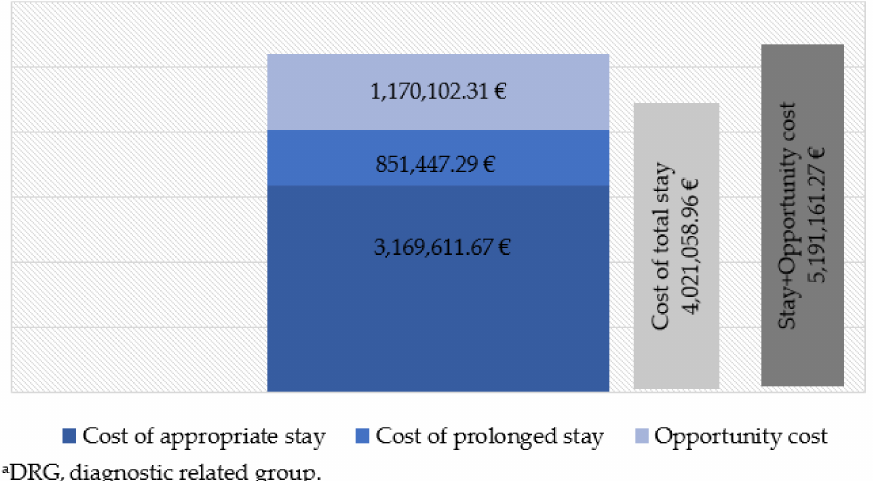
Figure 2. Costs of delayed discharge for non-clinical reasons in hip procedures. Model 2: on the basis of hospital stays that would correspond to the same DRG a and year. Cantabria (northern Spain),